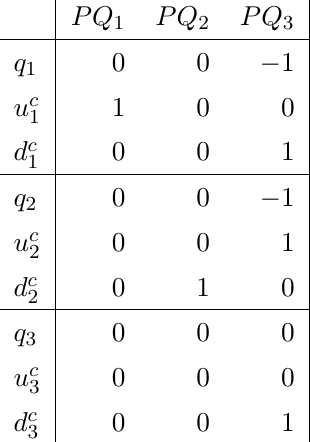
Table 2 . Particle charges under family PQ symmetries, for a simple 3-generation model with CKM mixings ( i; j = 1 ; 2 ;